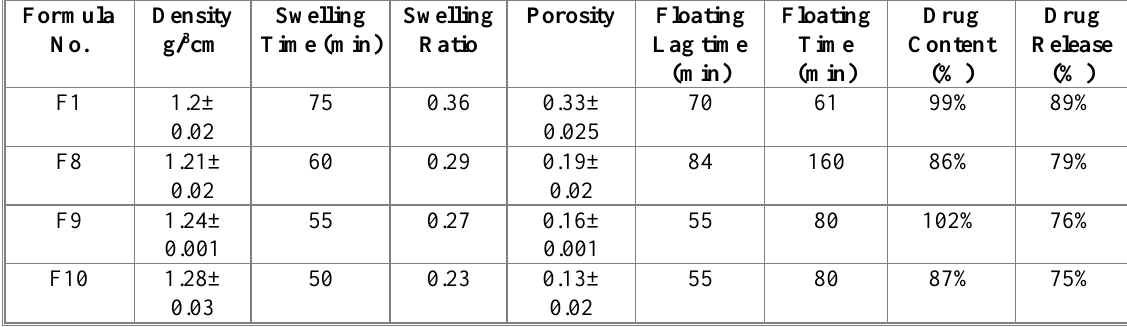
Table 5.Effect of Chitosan Concentration on SPH Hybrid Properties Formula